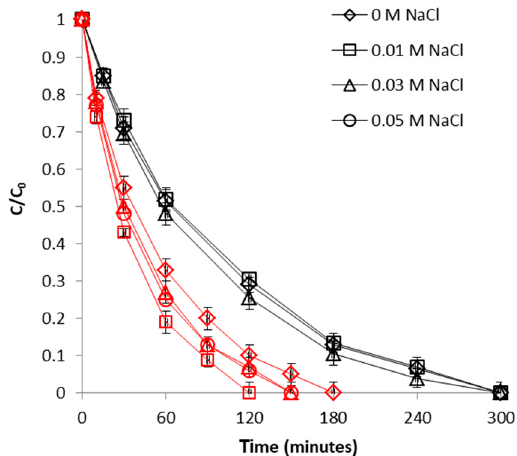
Figure 12. Effect of ionic strength on Cr VI removal by WSP-Fe 0 (red curves) and WSP (black curves). The lines are not fitting models; they simply connect points to facilitate visualization.